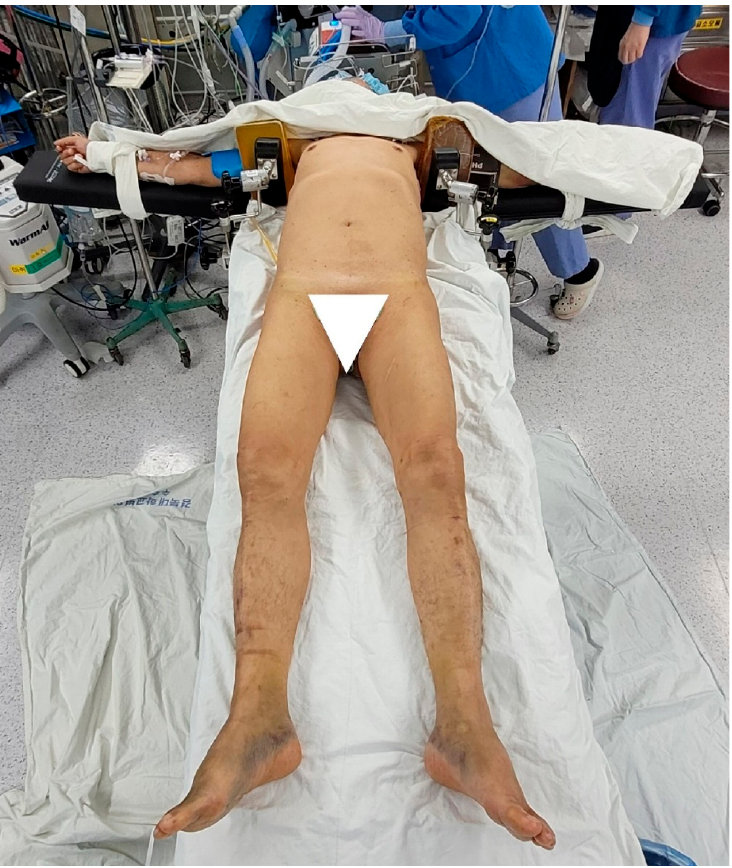
Figure 1. After anesthesia, the patient was placed in a supine position with both arms abducted at 90°. A shoulder support was placed on both axillae with a jelly pad to prevent the patient from getting pulled down while maintaining longitudinal traction with a limb positioner.